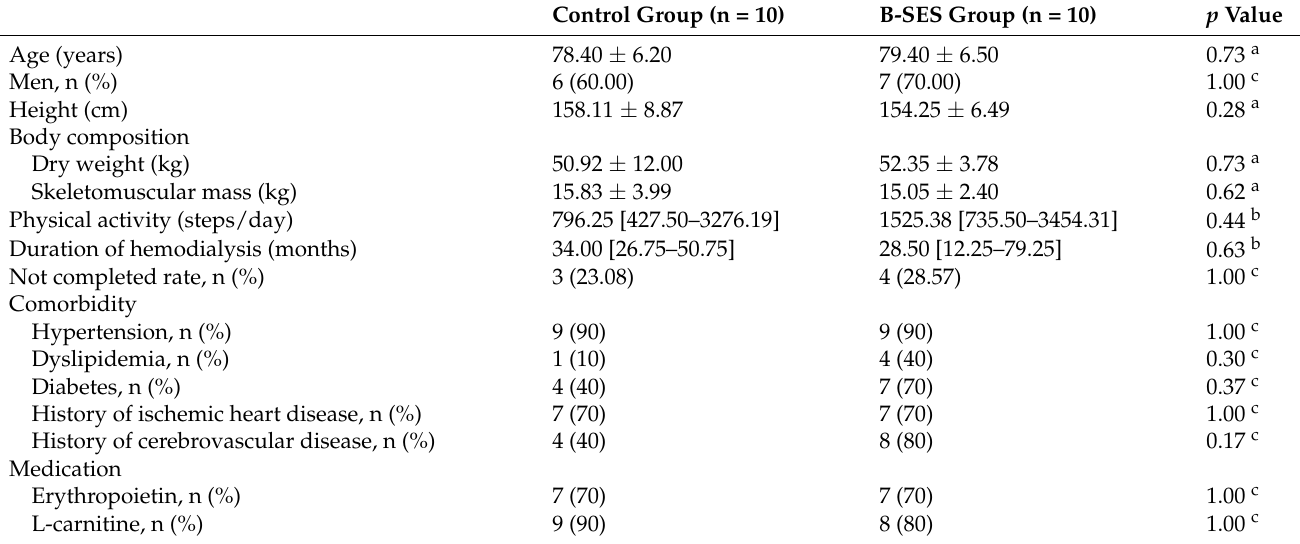
Table 1. Clinical